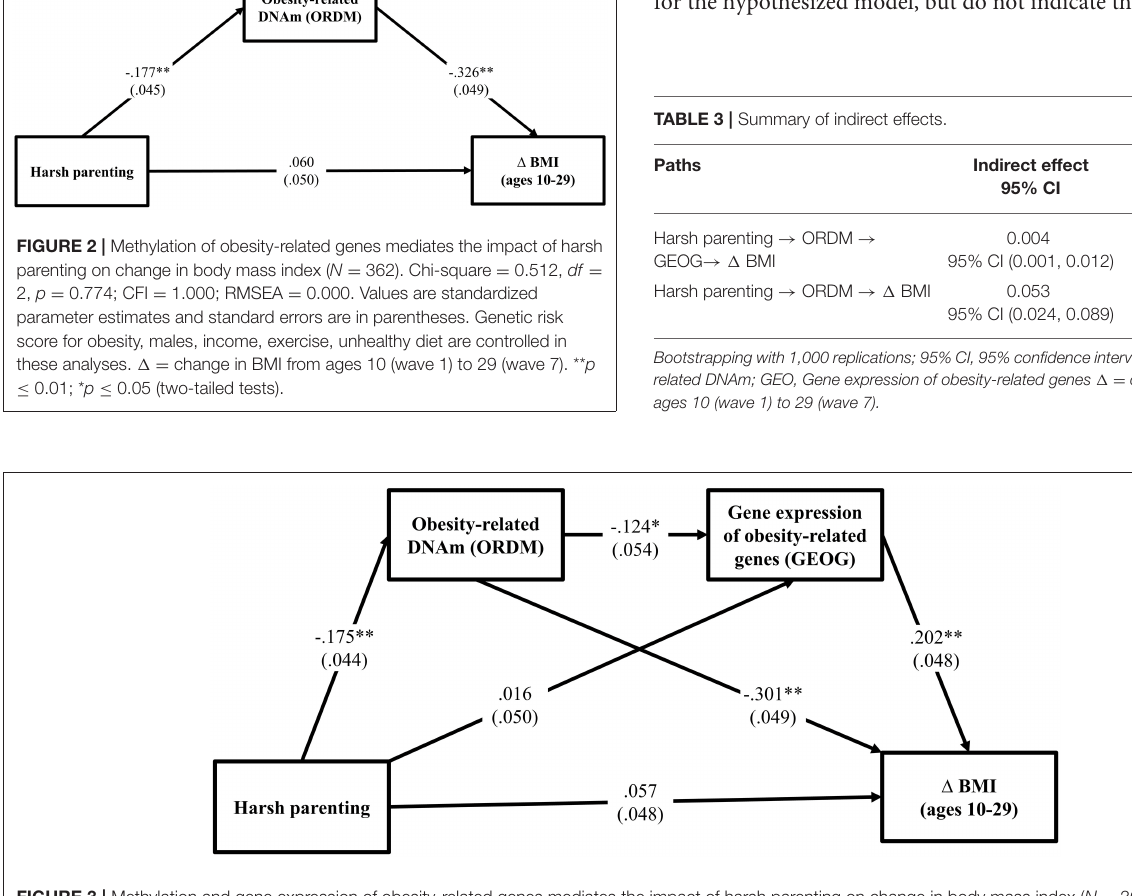
Frontiers in Cardiovascular Medicine |